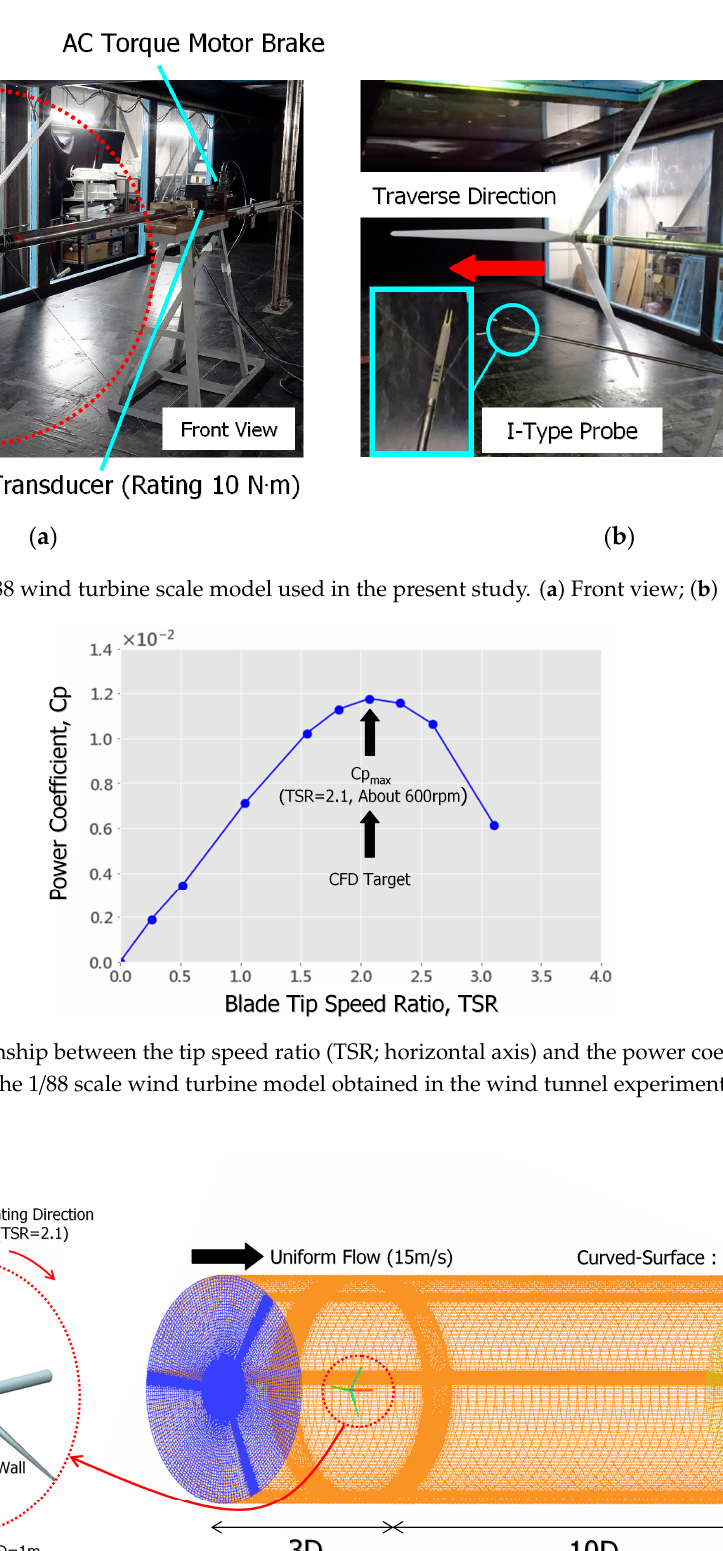
Figure 3. Wind tunnel facility used in the present study.